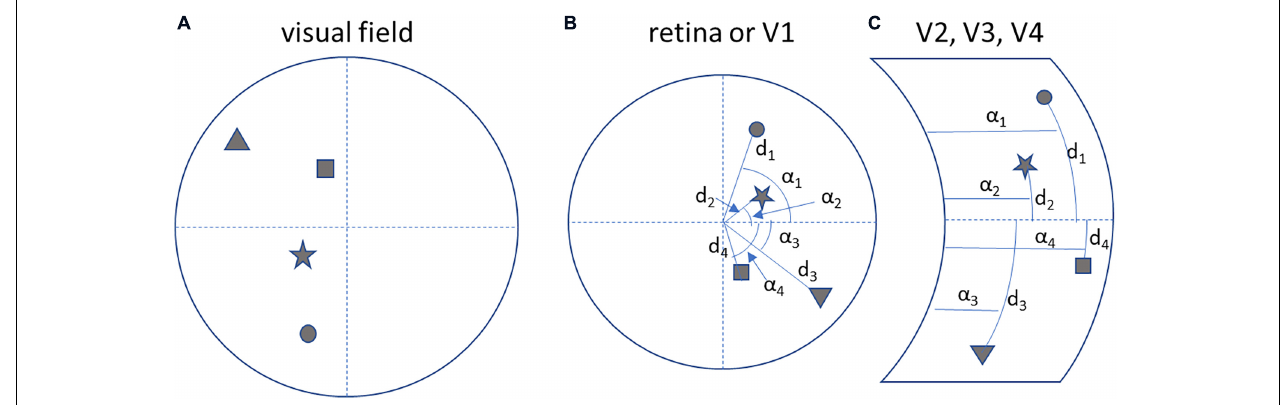
FIGURE 4 | Neuronal processing is self-centred and interaction oriented . (A) A hypothetical visual field. (B) The corresponding topological mapping of the image on the retina and on the primary visual cortex (V1). (C) The transformation of the topological mapping in the right associative visual cortices (V1 to V4): notice the transformation to a spherical coordinate system (angle α n and distance d n ), that helps to map objects in terms of the direction (azimuth and elevation) of a movement to reach